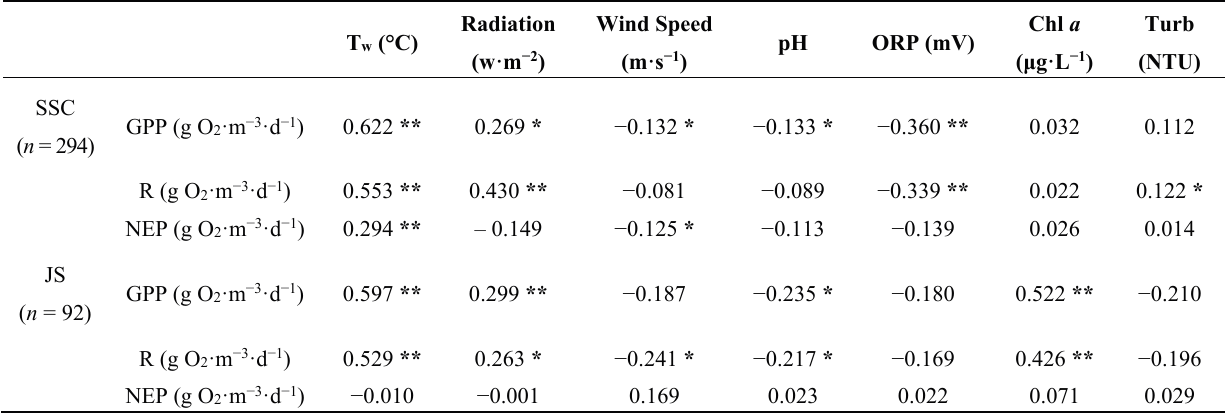
Table 1. Relationships between metabolism and environmental factors in Shangshancun (SSC) and Jinshu (JS) buoy stations.